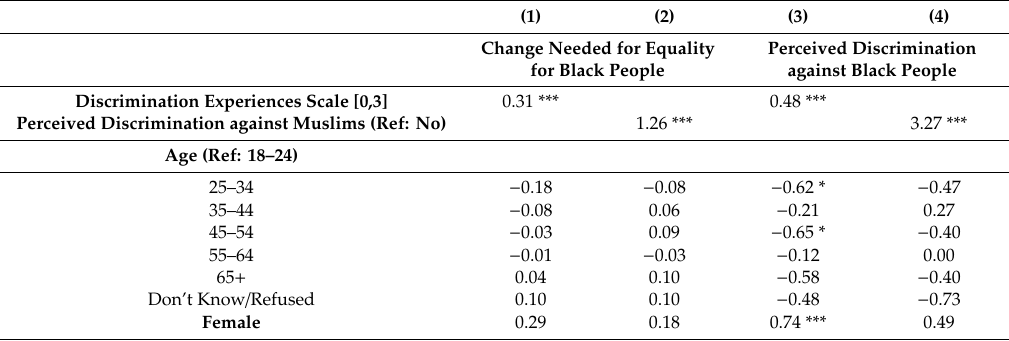
Table A4. Coe ffi cients from Logistic Regression Predicting Solidarity with Black People using Imputed